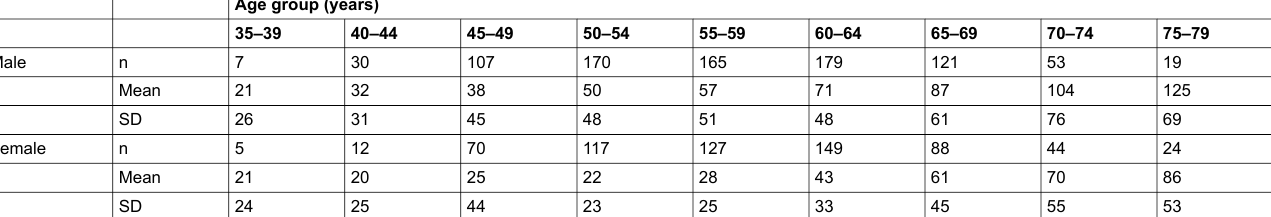
Table 2: Mean, standard deviation (SD) and number (n) of patients imaged to derive age- and sex-specific values for 5-year